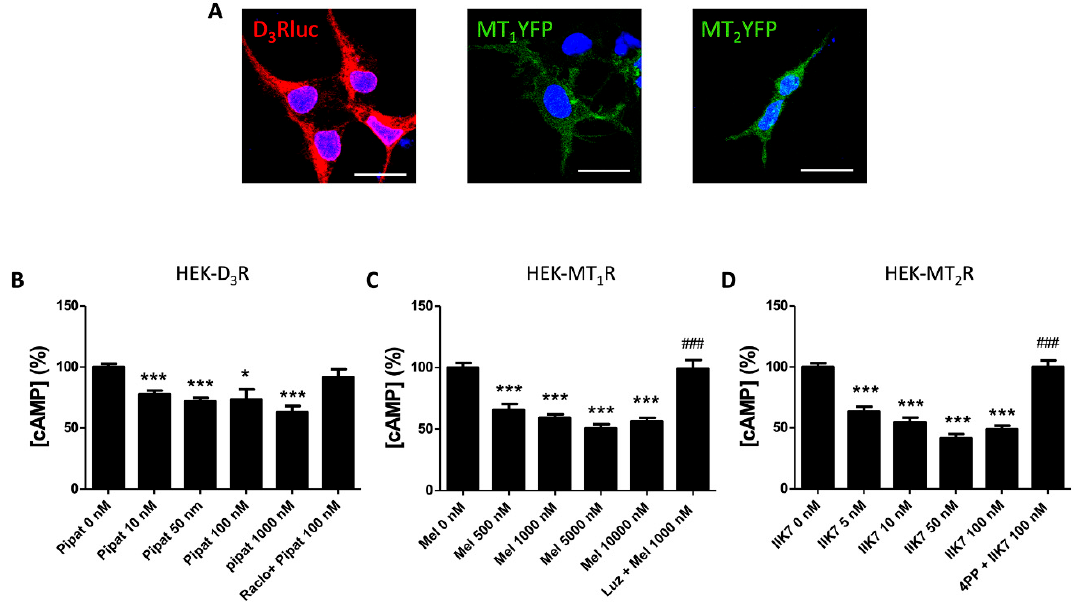
Figure A1. Membrane receptor expression and cAMP responses in single-transfected HEK-293T cells. ( A ) Confocal microscopy images of HEK-293T cells transfected with cDNAs for D 3 R-Rluc (2 µ g), MT 1 R-YFP (2 µ g), or MT 2 R-YFP (2 µ g). D 3 receptors (red) were identified by immunocytochemistry using anti-Rluc antibodies. MT 1 and MT 2 receptors (green) were identified from the fluorescence of YFP-containing fusion proteins. Cell nuclei were stained with Hoechst (blue channel). Scale bar: 20 μ m. Panels ( B – D ) HEK-293T cells transfected with cDNAs encoding for D 3 R (1.5 μ g) ( B ), MT 1 R (1.5 μ g) ( C ) or MT 2 R (1.5 μ g) ( D ) cells were pre-treated with vehicle or antagonists (1 μ M raclopride for D 3 R, 1 μ M luzindole for MT 1 R or 1 μ M 4PPDOT for MT 2 R), and